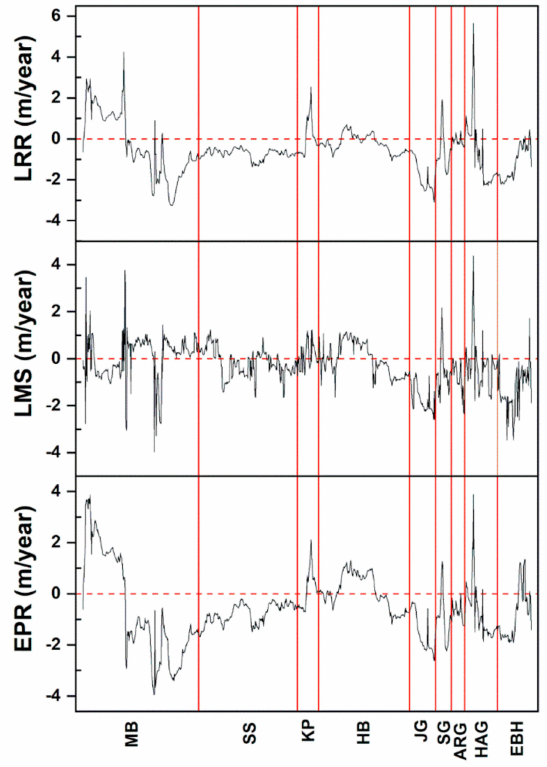
Figure 7. Shoreline change rate (EPR, LMS, LRR) of the western zone (MB = Manora Beach, SS = Sandspit, KP = Kaka Pir, HB = Hawks Bay, JG = Jamali Goath, SG = Somar Goath, ARG = Abdul Rehman Goath, HAJ = Haji Ali Goath, EBH = Engro Beach